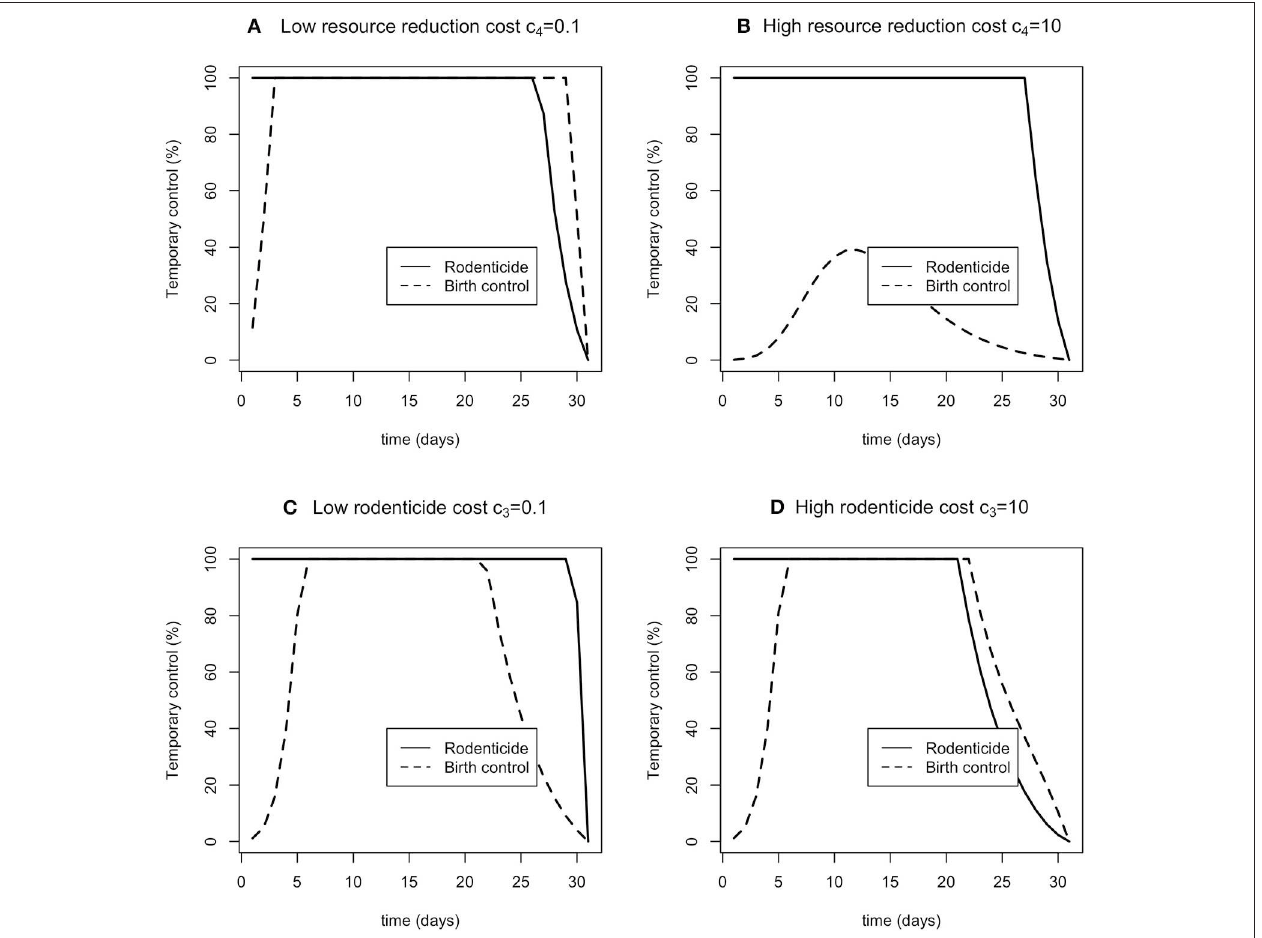
FIGURE 4 | The sensitivity of the optimal time dependent controls rodenticide (solid line) and resource reduction (dashed line) for low and high costs of rodenticide (A,B) and resource reduction (C,D)